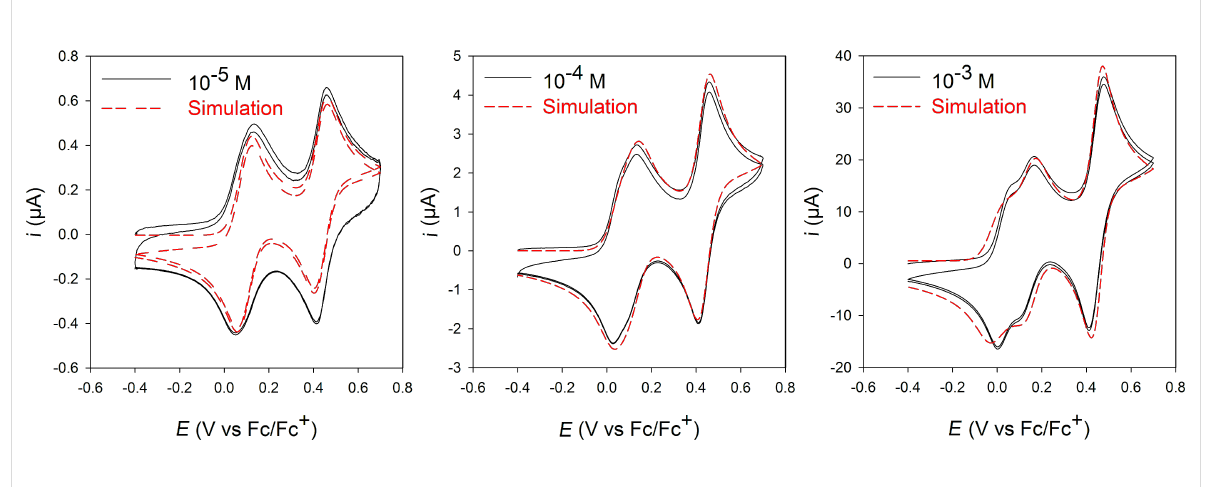
Figure 4: Cyclic voltammograms of molecular clip 2 at different concentrations (left: 10 − 5 M; middle: 10 − 4 M; right: 10 − 3 M) in 0.1 M TBAPF 6 /CH 2 Cl 2 / CH 3 CN 3:1 on a glassy carbon electrode at 100 mV·s − 1 . Red dashed line: electrochemical simulation performed from experiments ( E 1 = 0.090 V, E 2 = 0.165 V, E 3 = 0.435 mV, K MV = 11400 M − 1 , K DIM = 680 M − 1 , k f = 1 × 10 9 M − 1 ·s − 1 for all the forward reactions, α = 0.5 and k s = 0.01 cm·s − 1 for all the charge transfers).